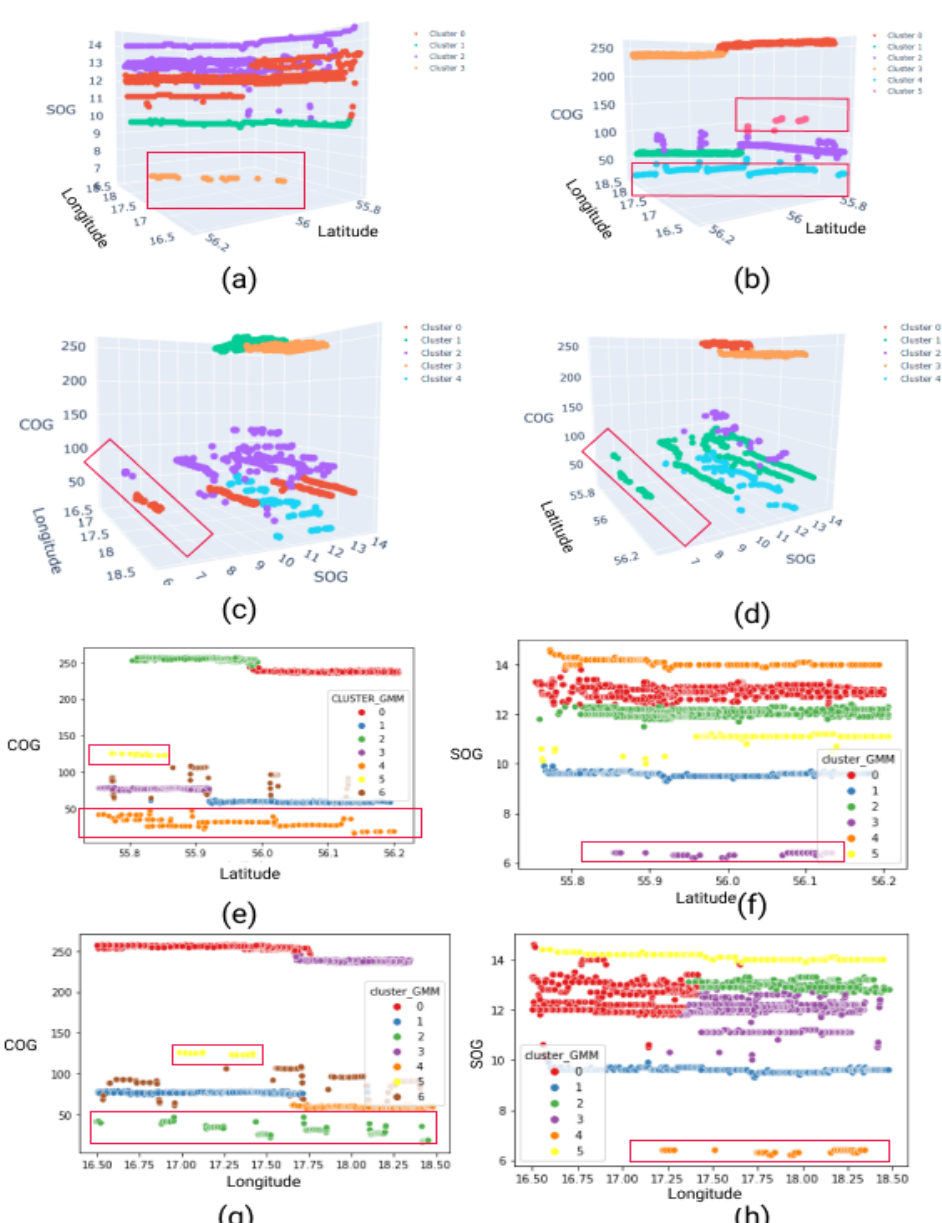
Figure 24. GMM clustering results based on the two and three-dimensional inputs ( a – h